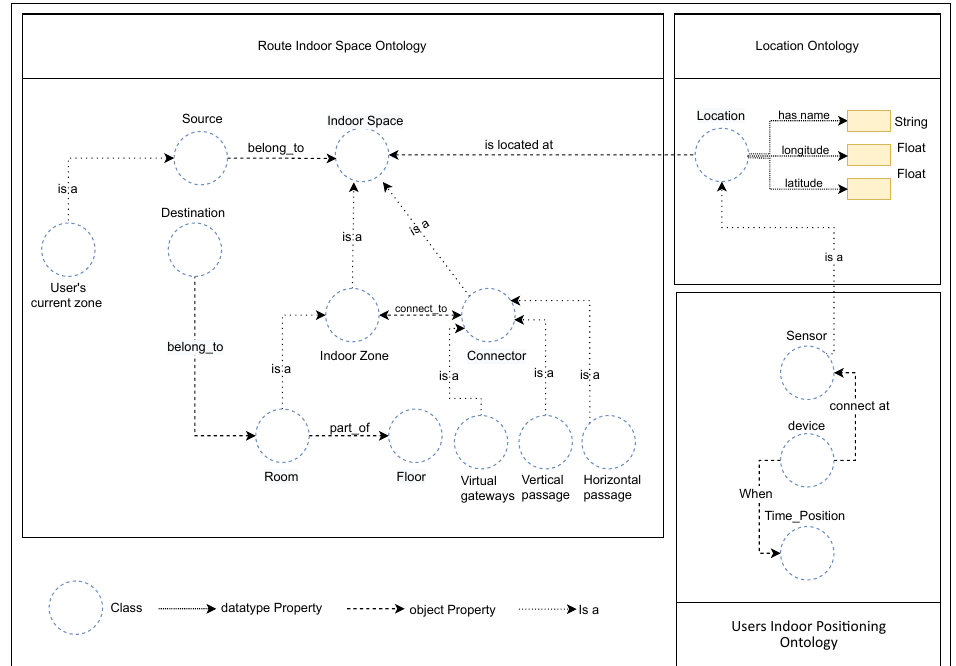
Figure 4. Semantic knowledge base for the indoor navigation